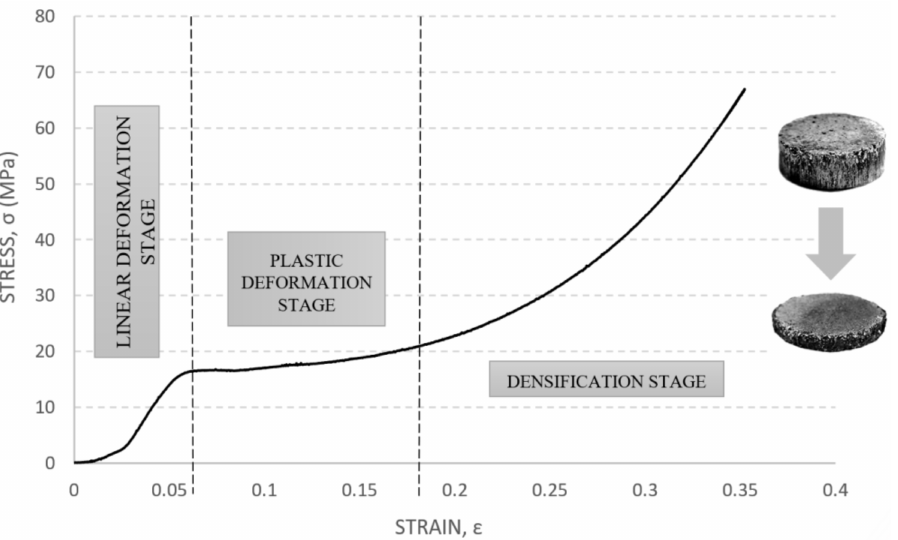
Figure 10. Stages of a typical stress-strain curve registered in an Al foam with 60 vol.% of design porosity.